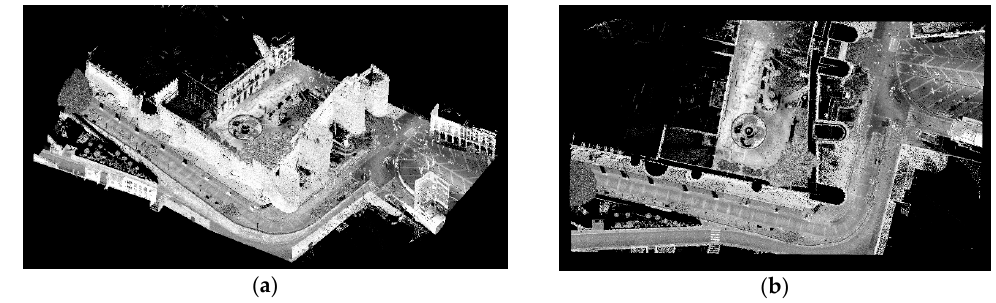
Figure 5. MLS 3D point cloud ( a ); and XY view ( b ) of the “Puerta del Alcázar” (Gate of the Fortress) of the Wall of Avila.